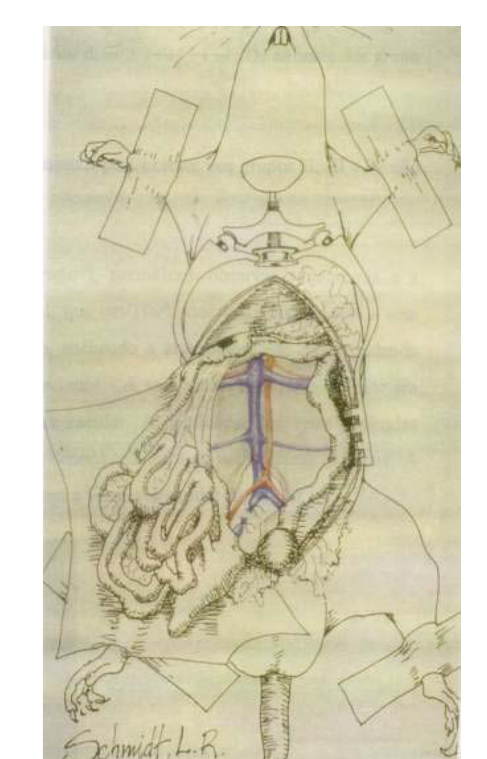
FIGURA 3 - Grupo IV, ligadura da veia Ilíaca comum